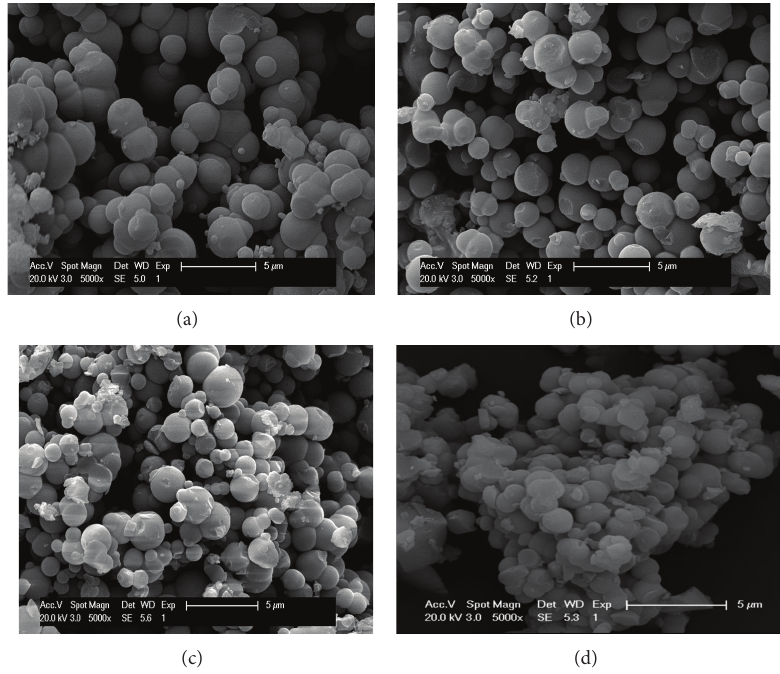
Figure 2: SEM images of the samples of C/TiO 2 (a), 0.1 wt% Pt-C/TiO 2 (b), 0.4 wt% Pt-C/TiO 2 (c), and 0.6 wt% Pt-C/TiO 2 (d),